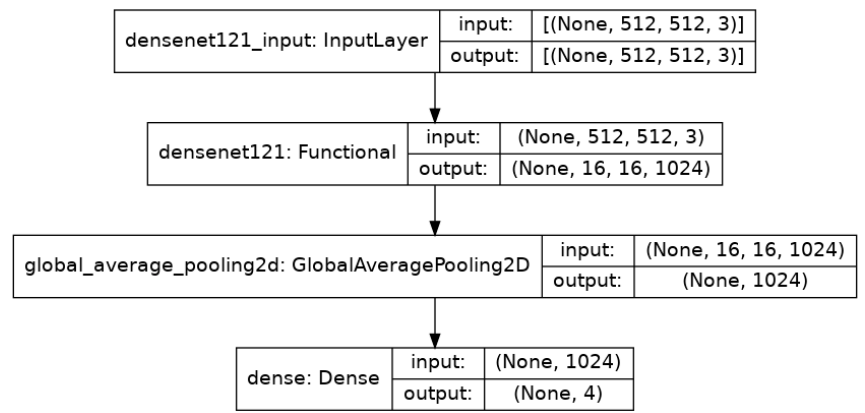
Figure 19. DenseNet fundamental block.